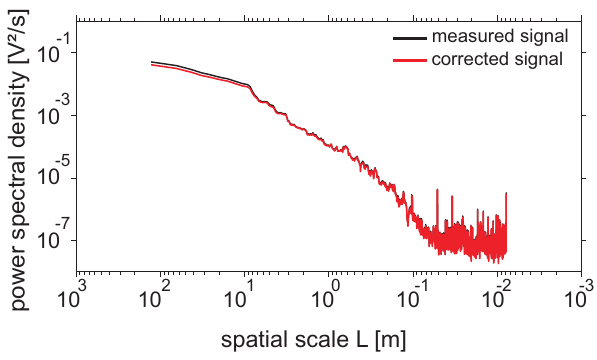
Fig. 8. Spectra of the corrected (red) and uncorrected (black) volt- age fluctuations from Fig.